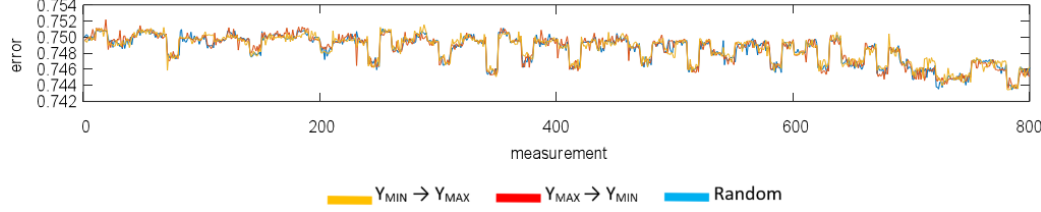
Figure 11. Deviations (mm) in the gradual and random selection of default positions, display for the robot flange (tool center point—TCP). Table 9. D-H parameters of ABB IRB 1200 5 / 0.9